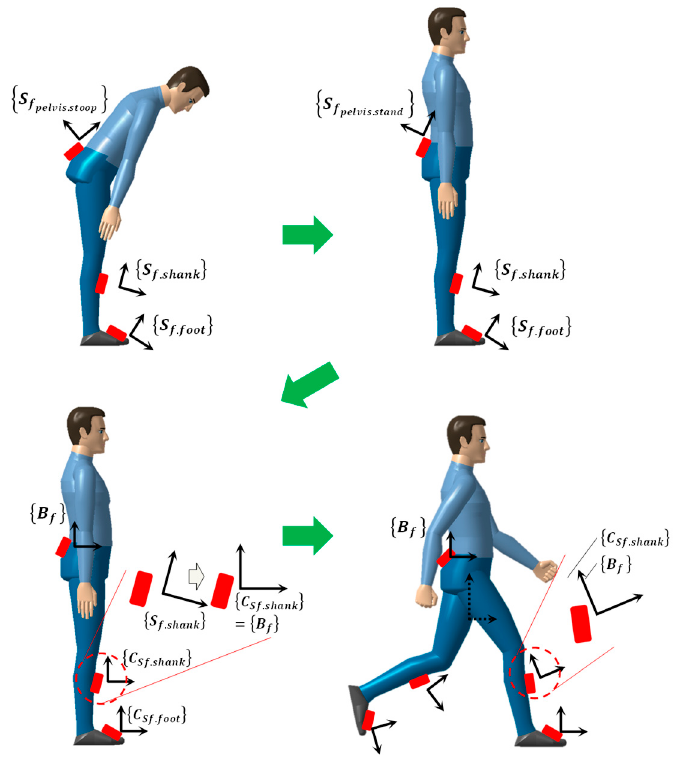
Figure 8. Procedure of standing–stooping calibration motion for creating a common sensor-fixed reference coordinate frame.